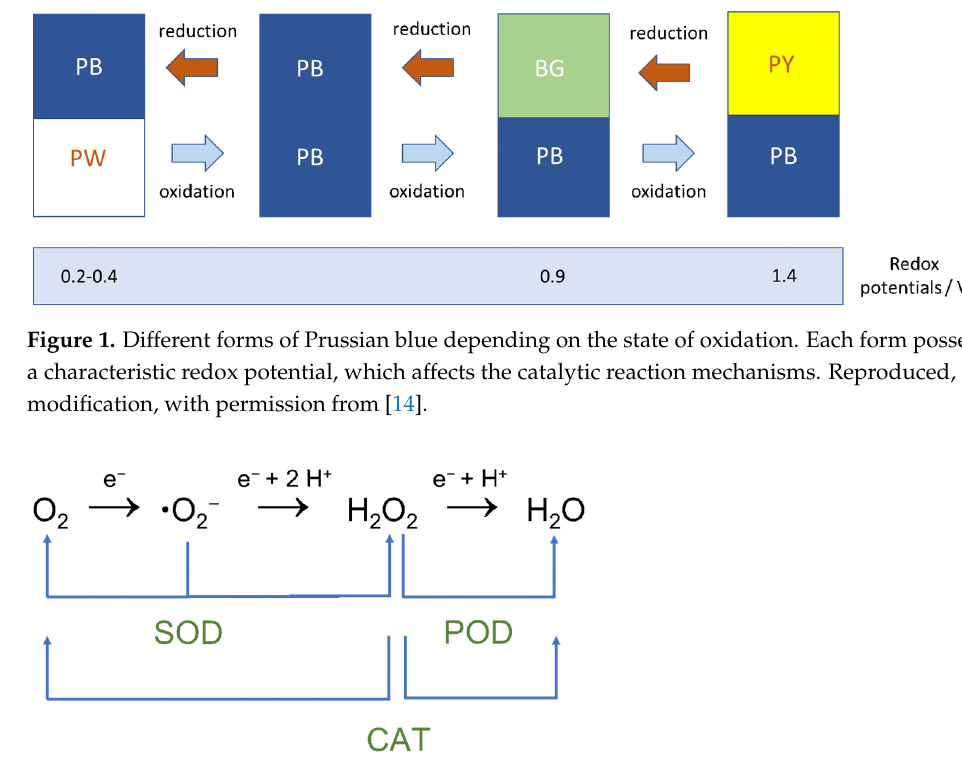
Figure 1. Different forms of Prussian blue depending on the state of oxidation. Each form pos- sesses a characteristic redox potential, which affects the catalytic reaction mechanisms. Repro- duced, after modification, with permission from [14].